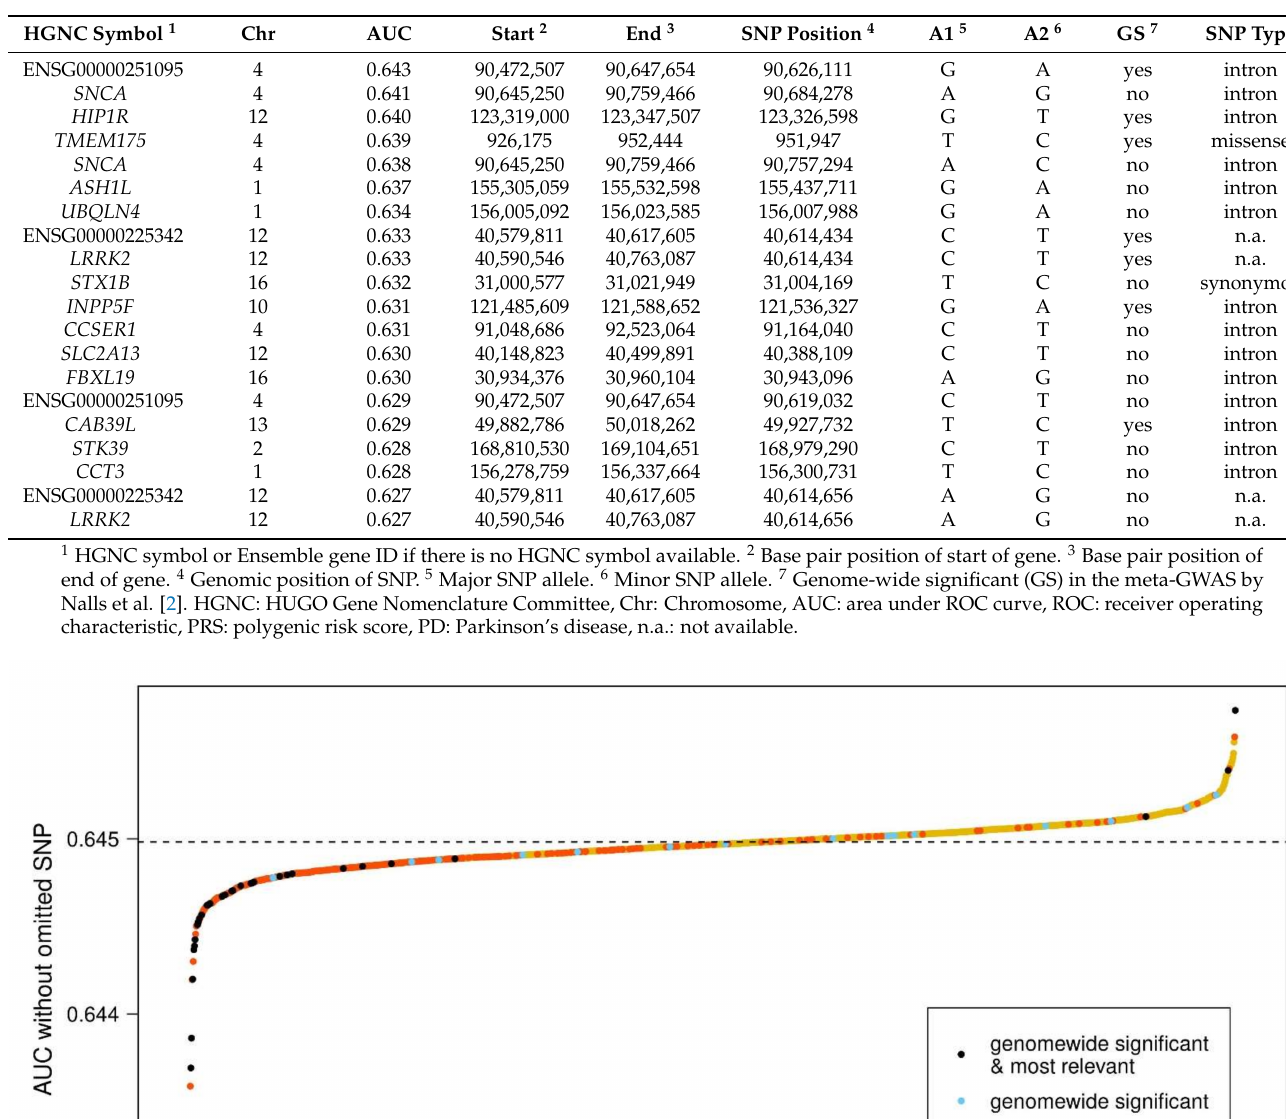
Table 2. Top 20 most relevant SNPs located within genes.